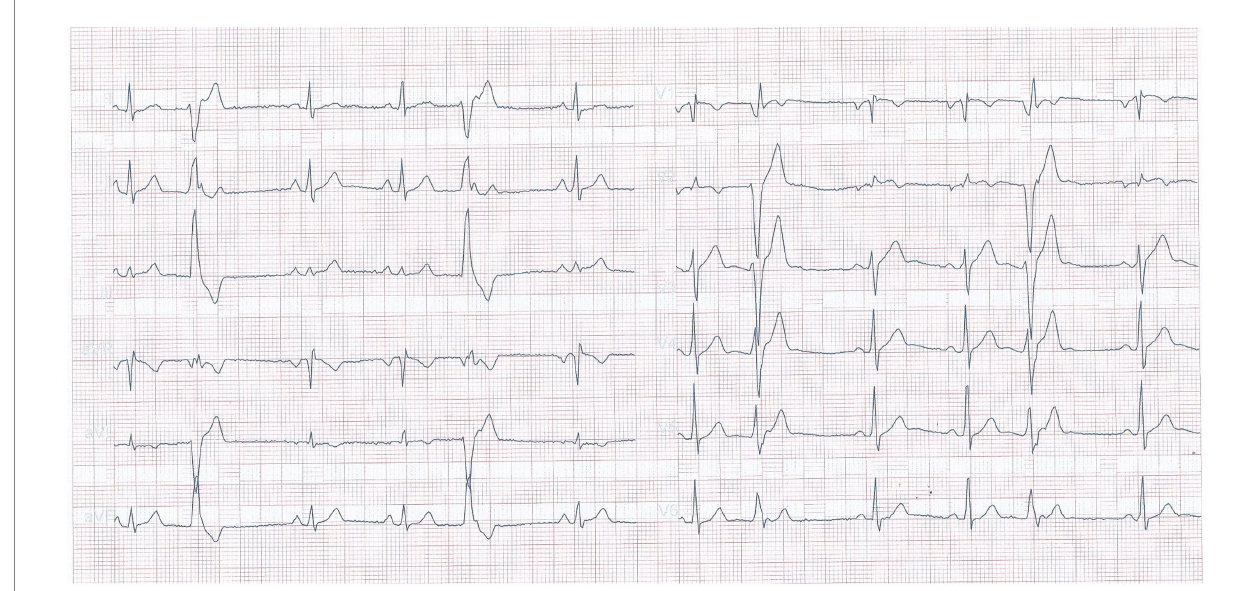
FIGURE 1 Electrocardiogram recorded during an emergency presentation, showing frequent premature ventricular